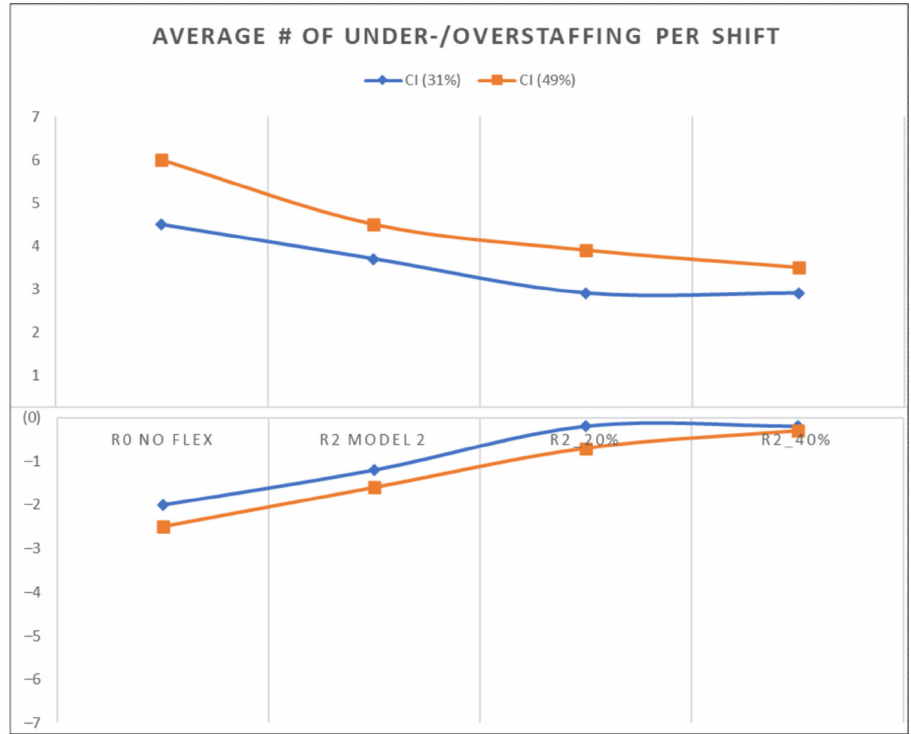
Figure 6. Results of the R2 modifications. The X-axis is the number of nurses, and the Y-axis is the different scenarios, including R0, R2, R2 with a 20% float pool, and R2 with a 40% float pool. The blue line represents the actual demand condition (CI:31%), while the red line represents highly variable demand (CI =